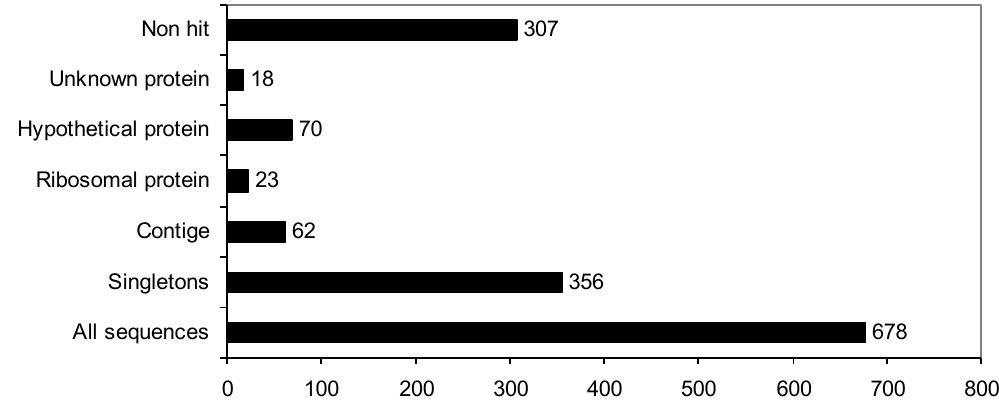
Figure 2. Blast results of 678 ESTs from S. reilianum obtained by macroarray